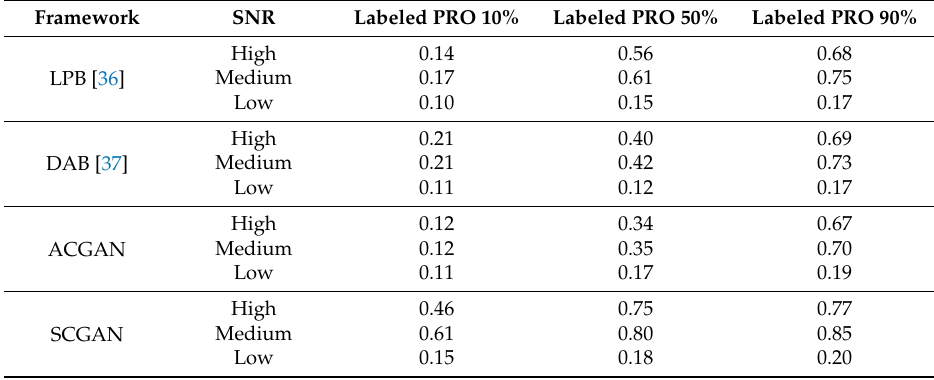
Table 6. Performance comparison for semi-supervised methods versus typical SNR.